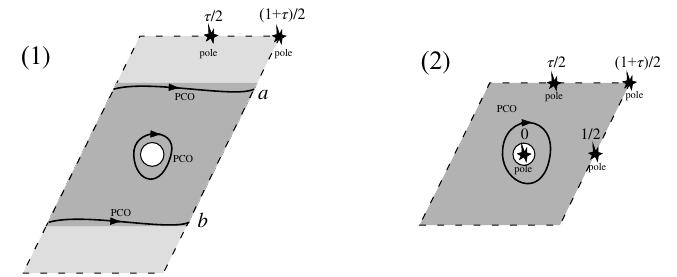
Figure 8 . PCO locations versus spurious poles for the various contributions to the tadpole ampli- tude computed with the contracting homotopy (4.60). Case (1) represents the propagator diagram with an NS state in the loop. With a Ramond state in the loop, the PCO insertion is the same as in (cid:12)gure 7. Case (2) represents the fundamental tadpole